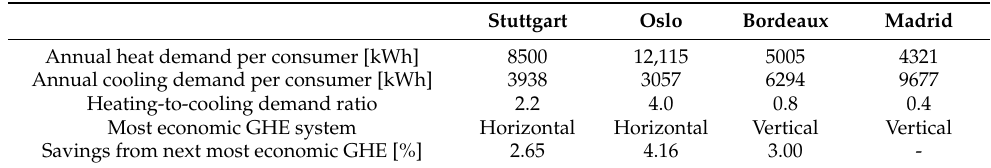
Table 10. Parameters of the three regional